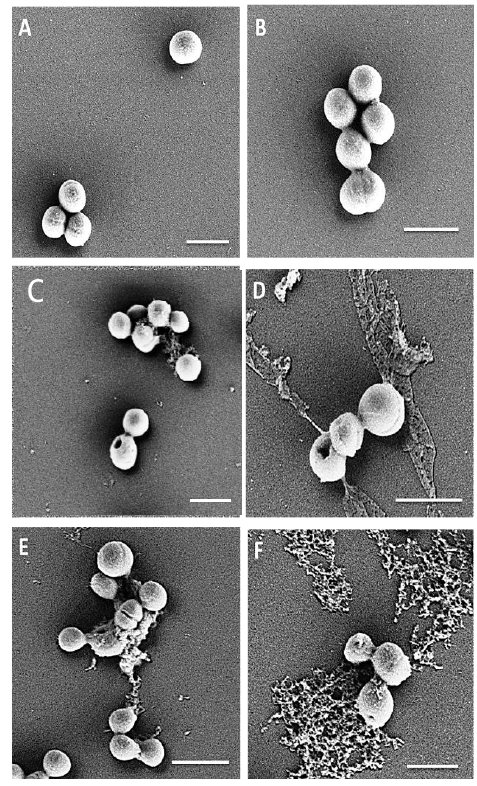
Figure 1. Scanning electron micrographs of MRSA M173525 planktonic cells treated with peptides at 1 × minimum inhibitory concentrations (MIC). ( A ) and ( B ): no-peptide control; ( C ): cells treated with P1 (16 μg/mL); ( D ): cells treated with PuroA (16 μg/mL); ( E ): cells treated with WW (4 μg\mL); ( F ): cells treated with W7 (8 μg\mL). Magnifications 40,000×, scale bar 1 µm.